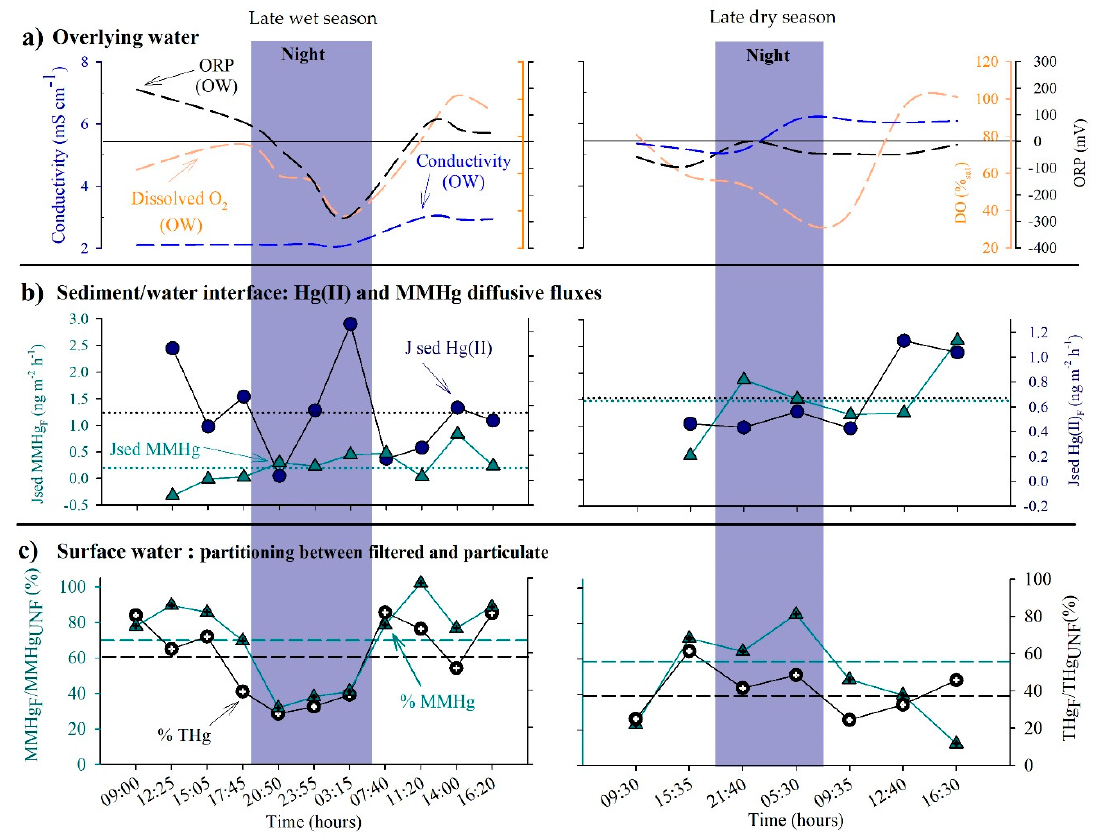
Figure 4. ( a ) Redox potential (ORP), dissolved oxygen saturation percentage (% sat ), and conductivity in overlying waters (OW) above the sediment–water interface (SWI); ( b ) filtered Hg(II) (=THg − MMHg) and MMHg diffusive fluxes (Jsed) at the SWI and ( c ) partitioning of THg and MMHg between filtered and particulate fractions in surface water, during the wet (left panels) and the dry (right panels) seasons. Lines represent averages for Jsed (dotted line) and for MMHg/THg ratios (dashed line).